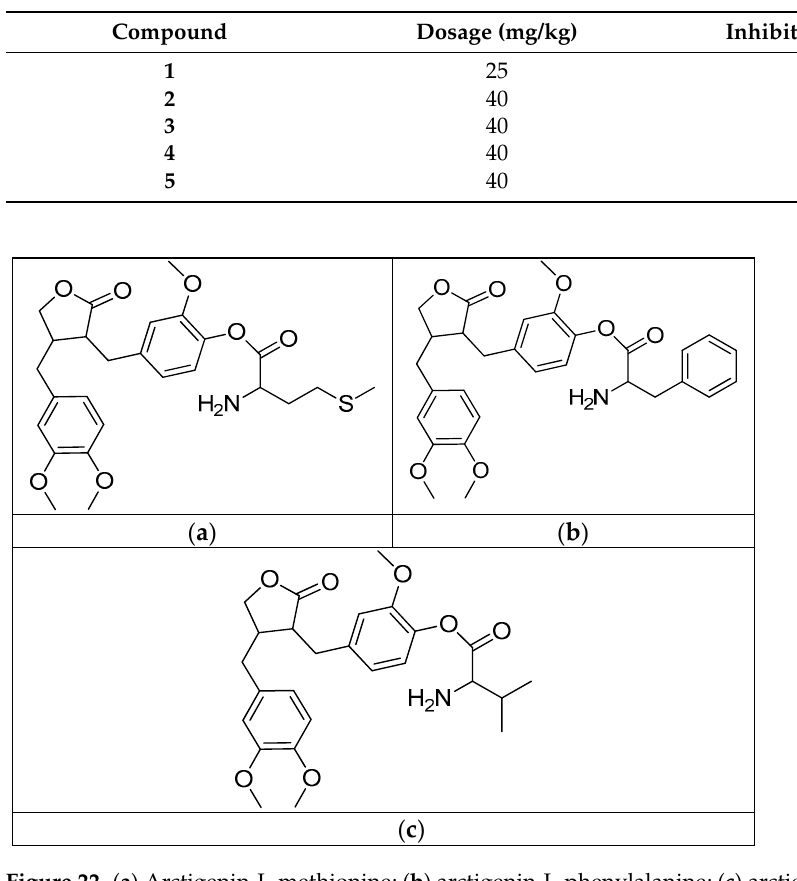
Table 11. Effects of arctigenin and its amino acid derivatives on tumour growth in H22 tumour- bearing mice. ( 1 ) Cyclophosphamide; ( 2 ) arctigenin; ( 3 ) arctigenin-L-methionine; ( 4 ) arctigenin-L- phenylalanine; ( 5 ) arctigenin-L-valine.